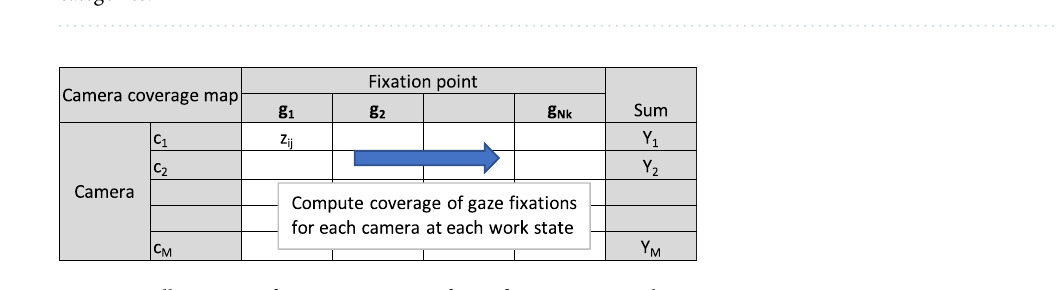
Figure 8. Gaze analysis approach to find common gaze attention (fixations) of operators from different categories.